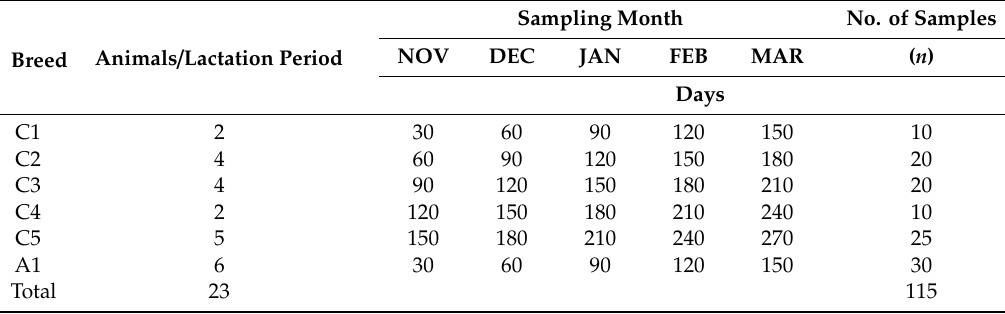
Table 1. The donkey milk sampling during the study